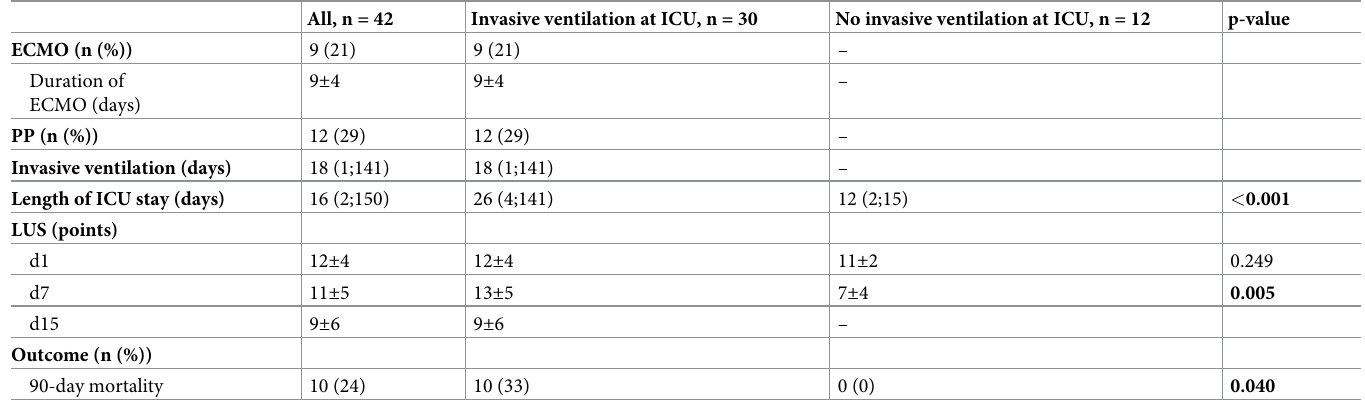
Table 3. Course of ICU. All, n = 42 Invasive ventilation at ICU, n =